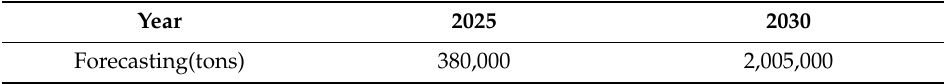
Table 2. Demand Forecast of LNG Bunkering Fuel in Busan